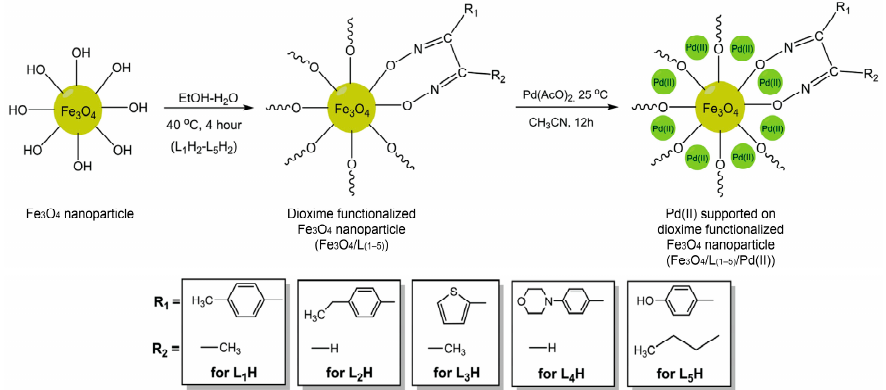
Figure 8. Synthesis of Pd(II) supported on dioxime functionalized Fe 3 O 4 nanoparticle, adapted with permission from [49] (p. 132) © 2019 Elsevier.